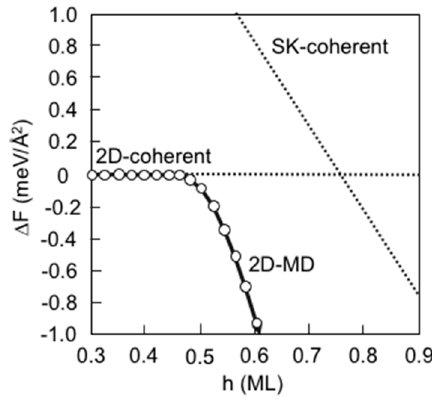
Figure 12. Calculated free energy differences ∆ F for various growth modes for the InAs/GaAs(001) as a function of layer thickness h .